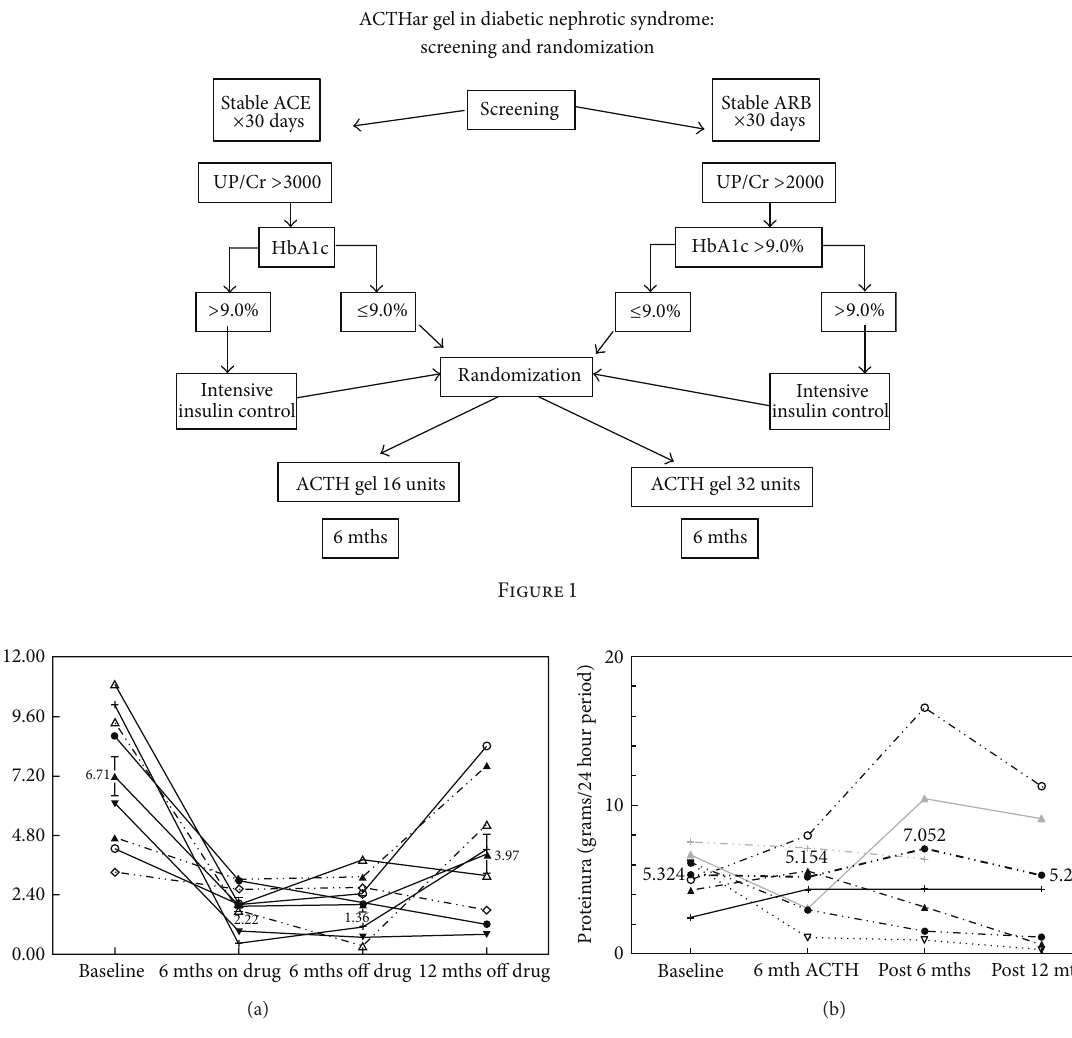
Figure 2: (a) 24-hour urinary protein (grams/24hrs) is shown for each patient randomized to receive 16 units of ACTH gel SQ daily. Mean proteinuria decreased significantly after six months of therapy. Proteinuria tended to fall for 6 months after stopping ACTH therapy but did not reach statistical significance. (b) 24-hour urinary protein (grams/24hrs) is shown for each patient randomized to receive 32 units of ACTH gel SQ daily. Mean proteinuria did not decrease after six months of therapy. Proteinuria tended to increase during the six months after stopping ACTH therapy but did not reach statistical significance. Two patients, including one with a late response, achieved a sustained partial